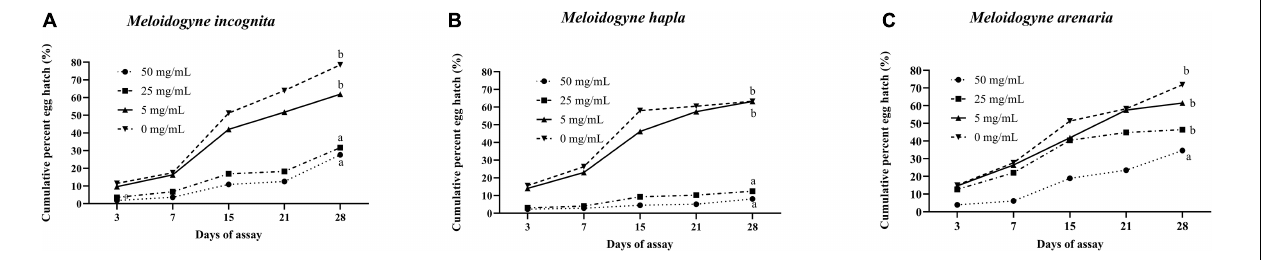
FIGURE 1 | Effect of cyclopiazonic acid on cumulative percent of egg hatch of Meloidogyne incognita (A) , Meloidogyne hapla (B) , and Meloidogyne arenaria (C) . Different letters above bars indicate statistical significance based on Tukey–Kramer/Tukey’s HSD test ( P ≤ 0.05). Each value represents the mean ± standard deviation of two experiments with three